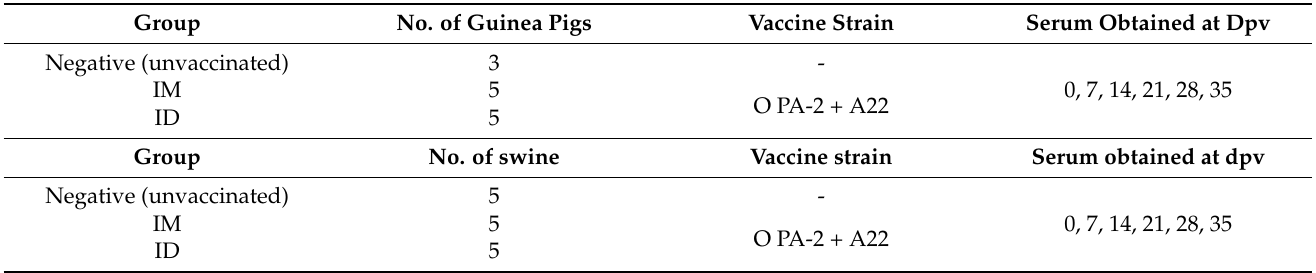
Table 1. Experimental designs of vaccination methods.